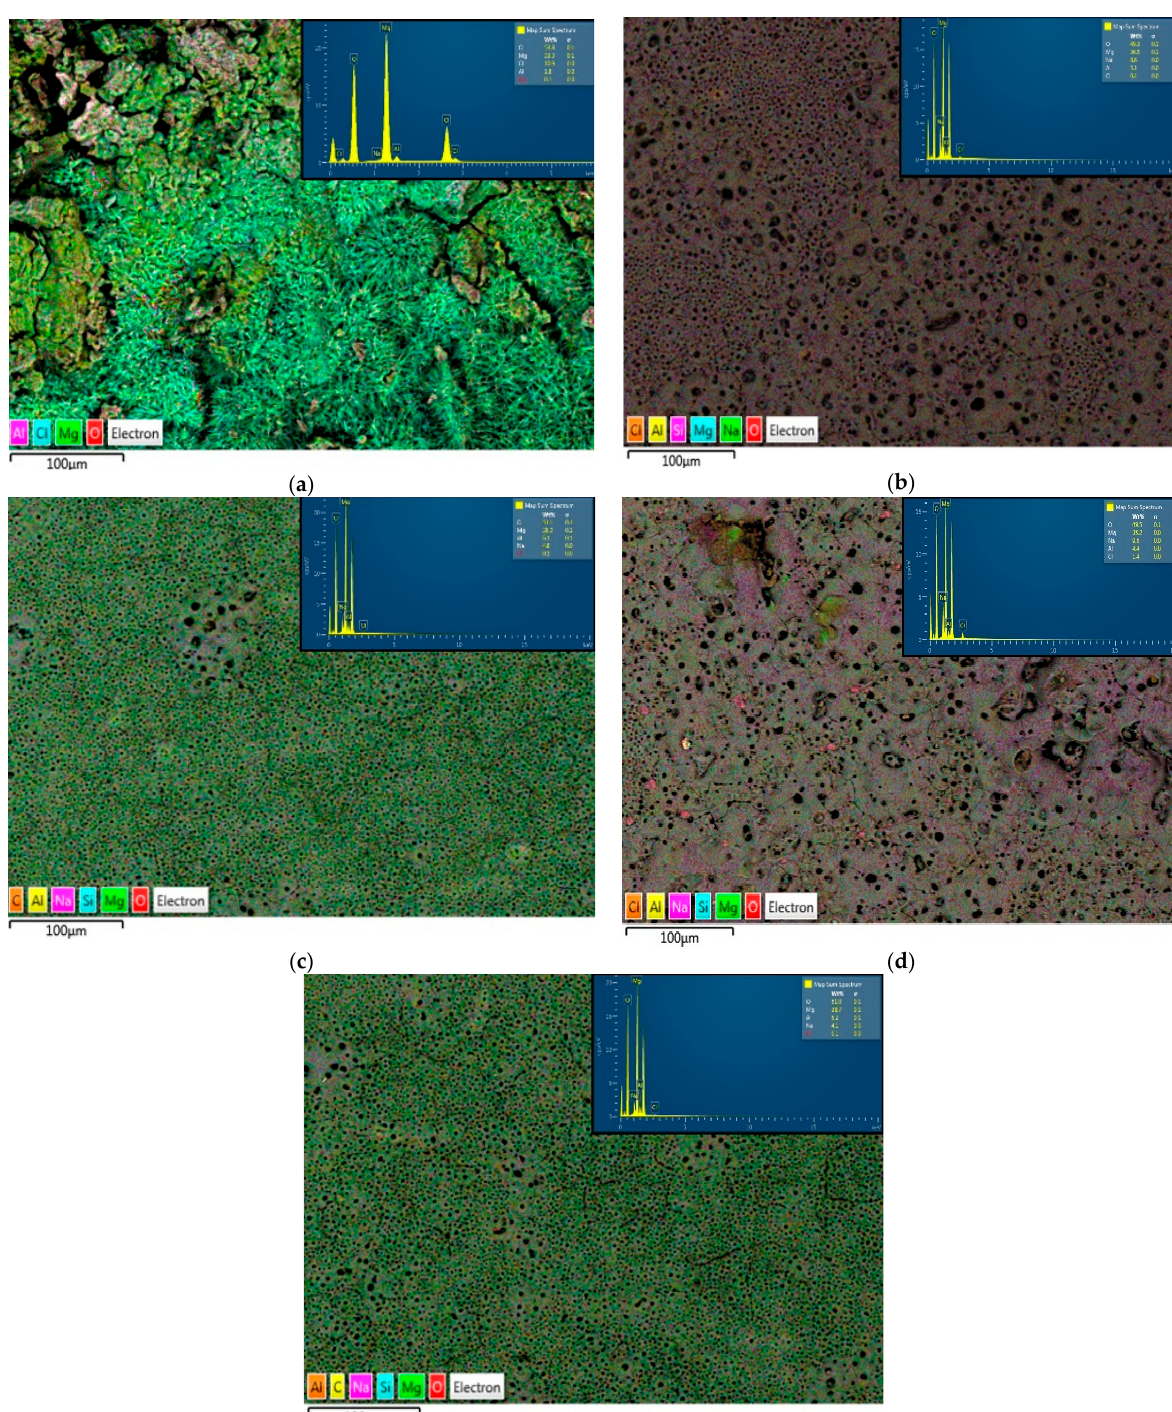
Figure 6. SEM images and EDS analysis after corrosion test: ( a ) BM, ( b ) UP, ( c ) BP30, ( d ) BP50 and ( e ) BP66.